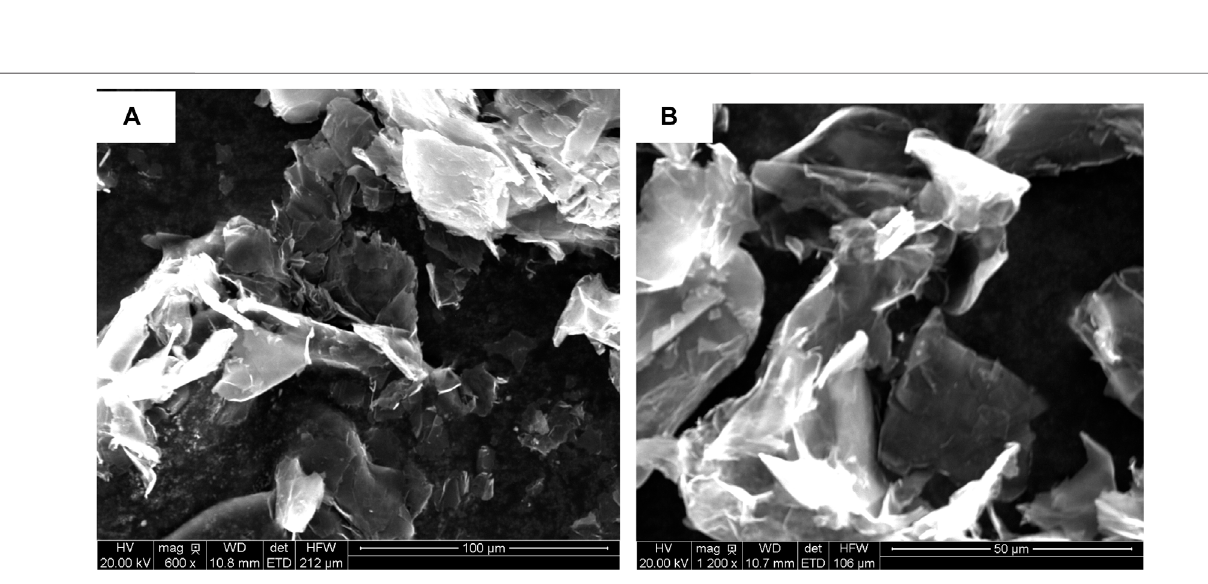
FIGURE 4 | SEM images of dispersed G in xylene solvent at low magni fi cation (A) and high magni fi cation (B) .